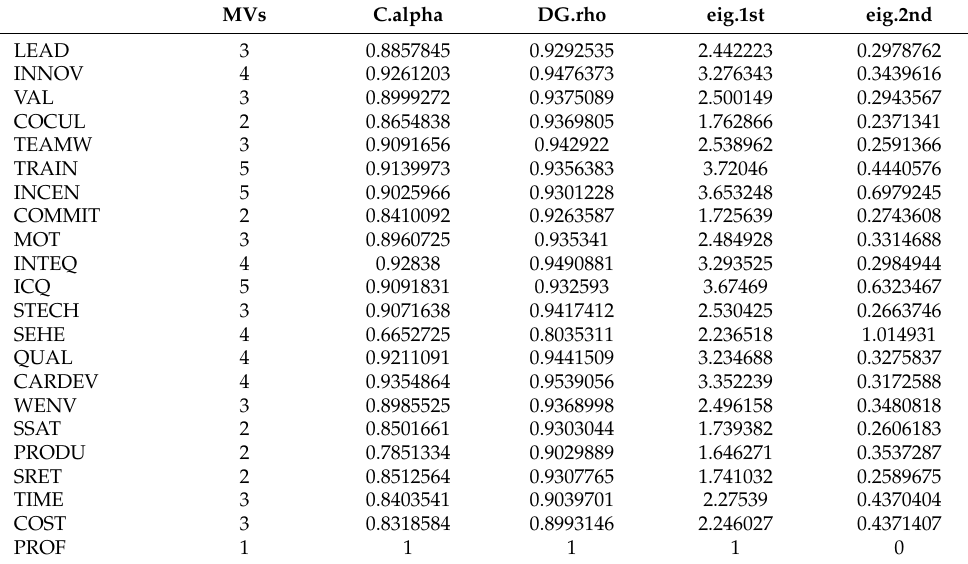
Table 7. Indices of Unidimensionality.